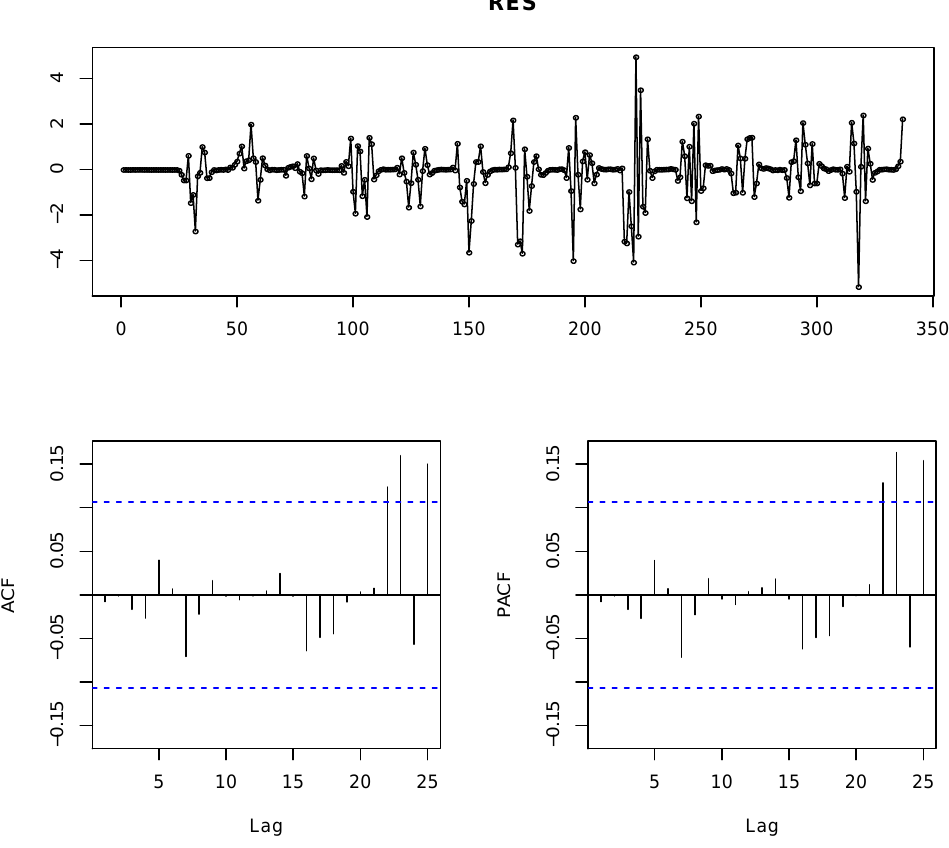
Figure 4. Time series display of residuals from model M8 after correcting for autocorrelation.